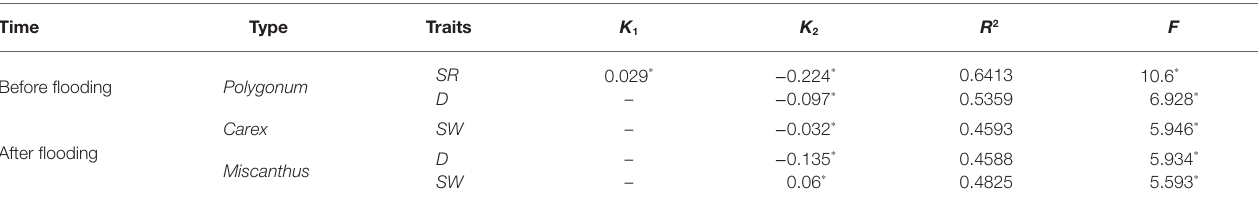
TABLE 2 | Summary of regression analysis of C. brevicuspis , M. sacchariflorus, and P. hydropiper community traits (species richness, density, biomass, and Shannon index of diversity) from 2011 to